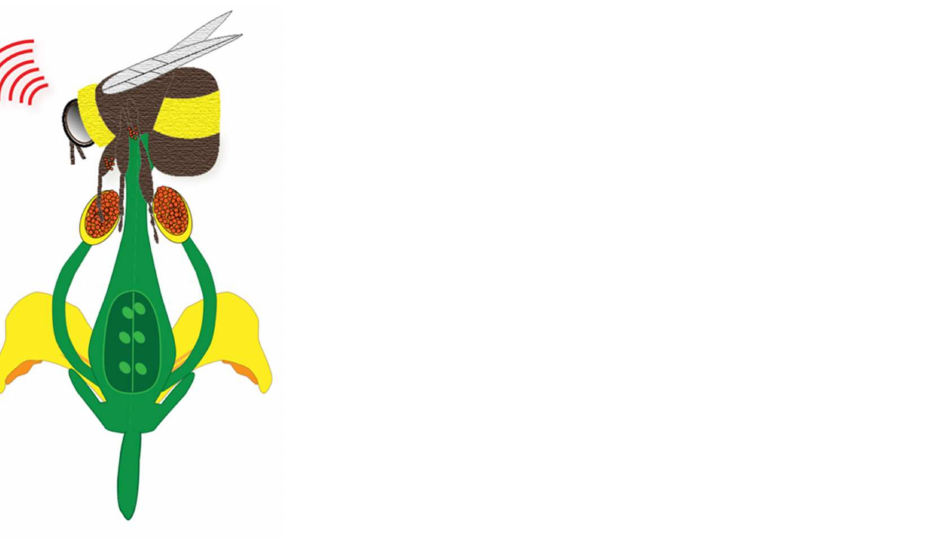
Figure 5. Stylised diagram of a bee buzzing a tomato flower. Bumblebees grasp the anther cone with their mandibles and vibrate their thorax. The mechanical and acoustic vibrations accelerate movement of the poricidal anthers to release pollen that can self-pollinate the tomato flower